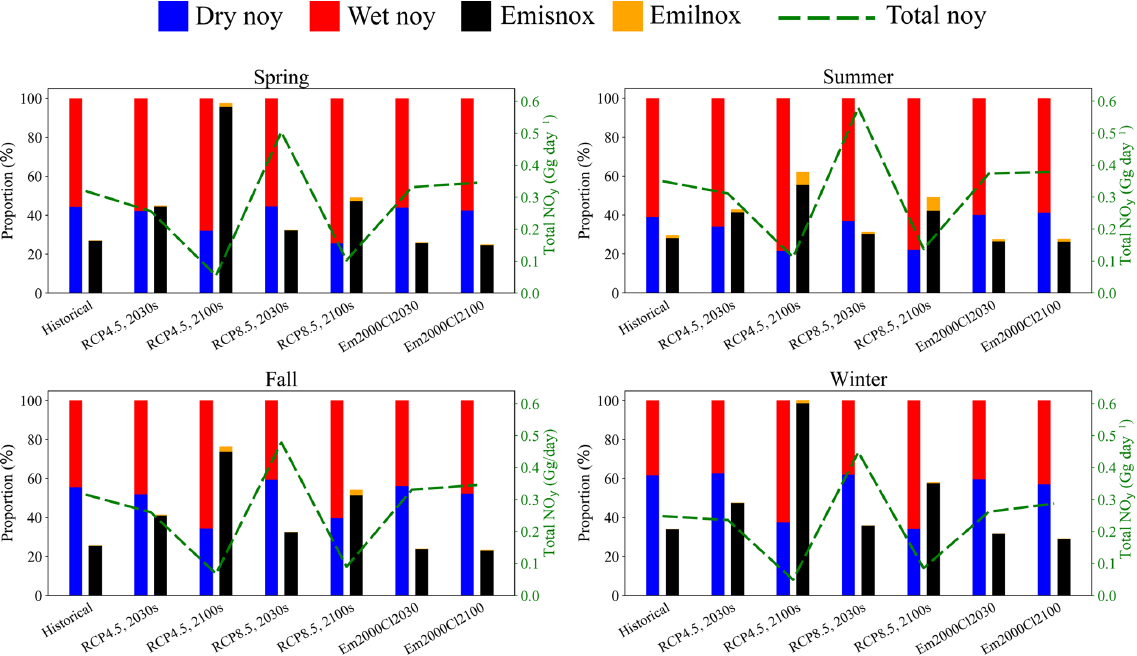
Figure 7. Stacked bars of the seasonal ratio of NO y deposition from wet (wetnoy) and dry (drynoy) deposition and NO x emissions from shipping (emisnox) and lightning (emilnox) to the total (wet + dry) NO y deposition in the historical and RCP scenarios over the Yellow Sea. Two color bars are shown for each period with the left one representing dry NO y (blue) and wet NO y (red) deposition and the right one representing emisnox (black) and emilnox (orange). A green dashed line representing total NO y deposition is added to each panel with the y axis on the right.